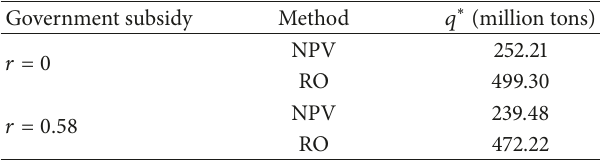
Table 3: Demand threshold with and without consideration of government subsidies under the RO and NPV